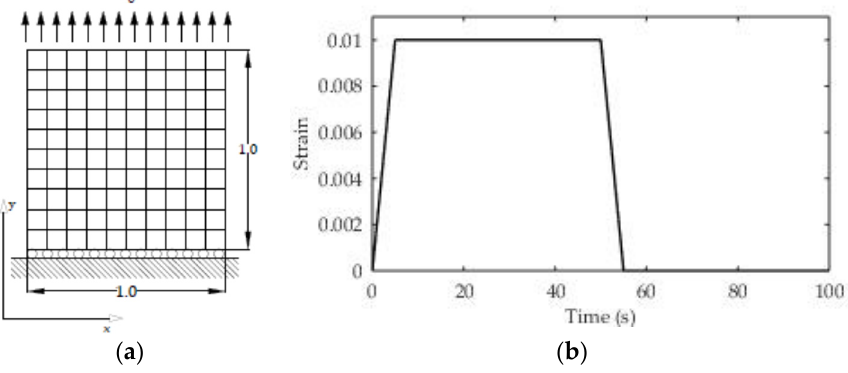
Figure 18. ( a ) Geometry and numerical mesh; ( b ) results of creep recovery test.